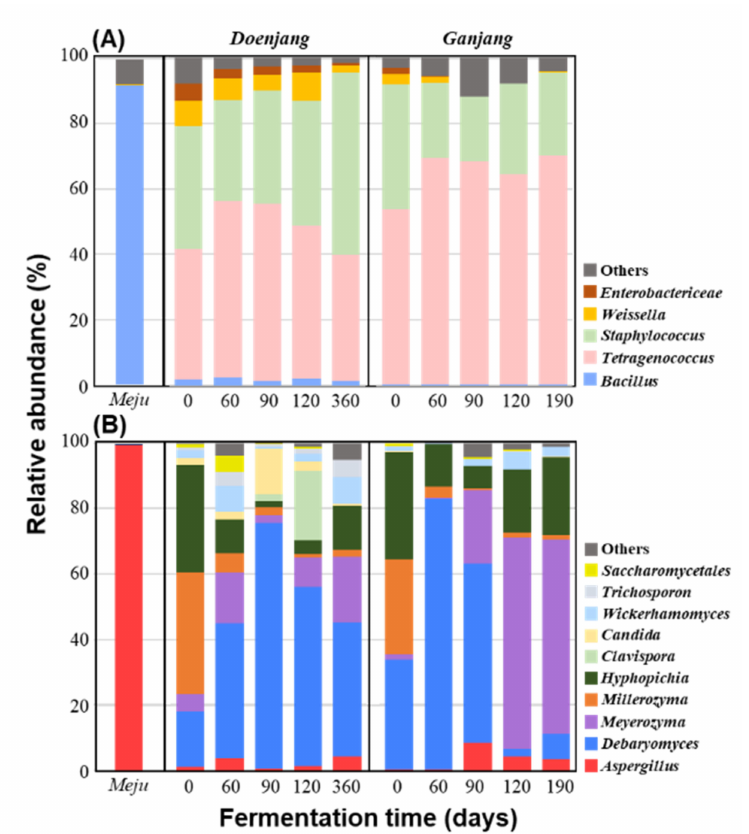
Figure 5. Taxonomic classification of the bacterial 16S rRNA and fungal ITS2 sequences at the genus level showing bacterial ( A ) and fungal ( B ) community changes during doenjang and ganjang fermentation with the bacterial and fungal communities of meju . “Others” comprise bacterial and fungal genera with less than 5.0% prevalence in all